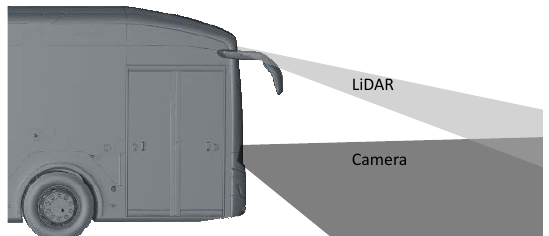
Figure 1b. Sensor setup at the test vehicle’s front for low-level data fusion of camera (center) and LiDAR (top) as seen from the